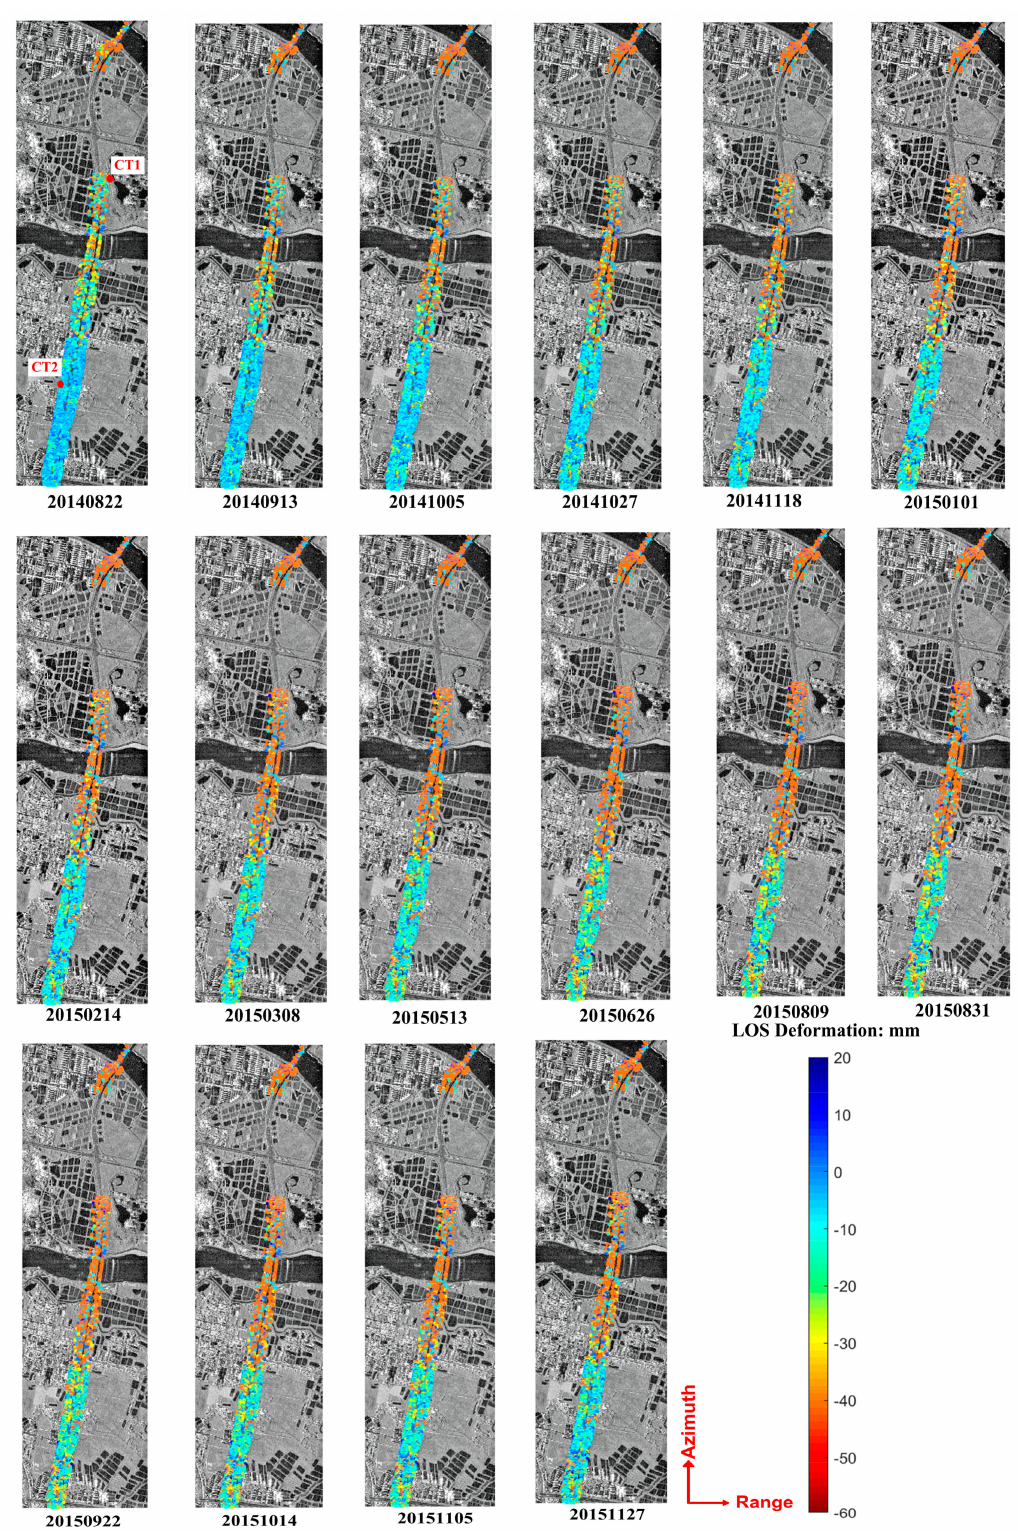
Figure 9. Time-series deformation over the tested area (with reference to 17 June